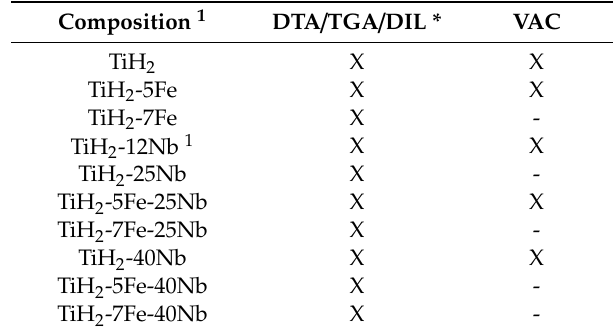
Table 1. Analyzing methods for the di ff erent compositions prepared. Composition 1 DTA / TGA / DIL